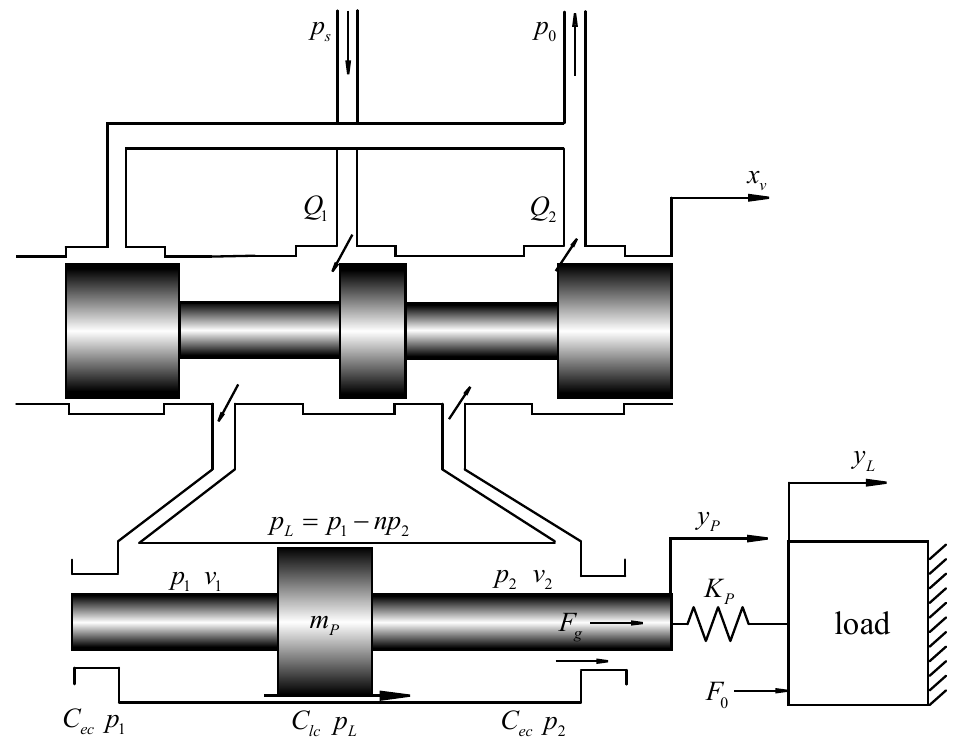
Figure 2. Structure diagram of zero opening four-way slide